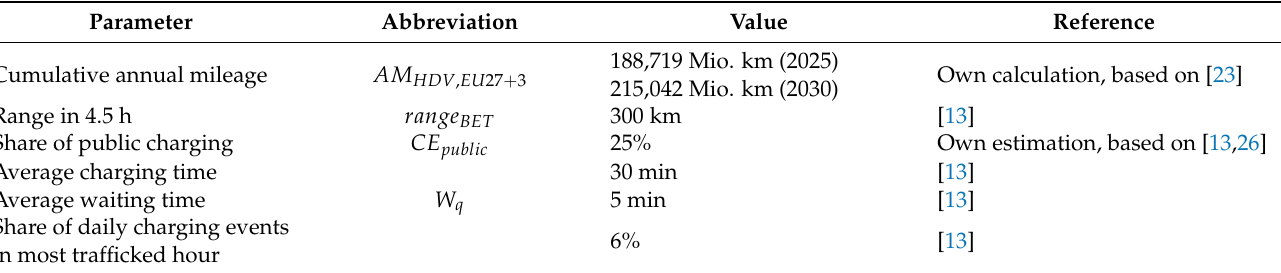
Table 1. Input parameters for infrastructure calculation.